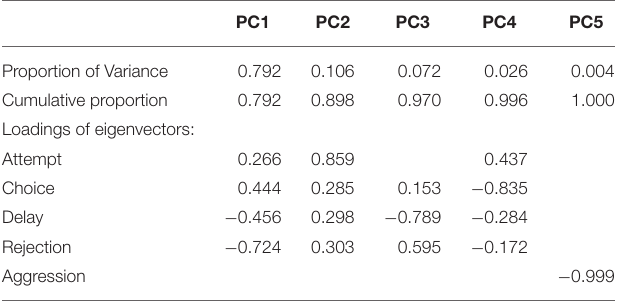
TABLE 4 | Tabulated representation for the principal component analysis